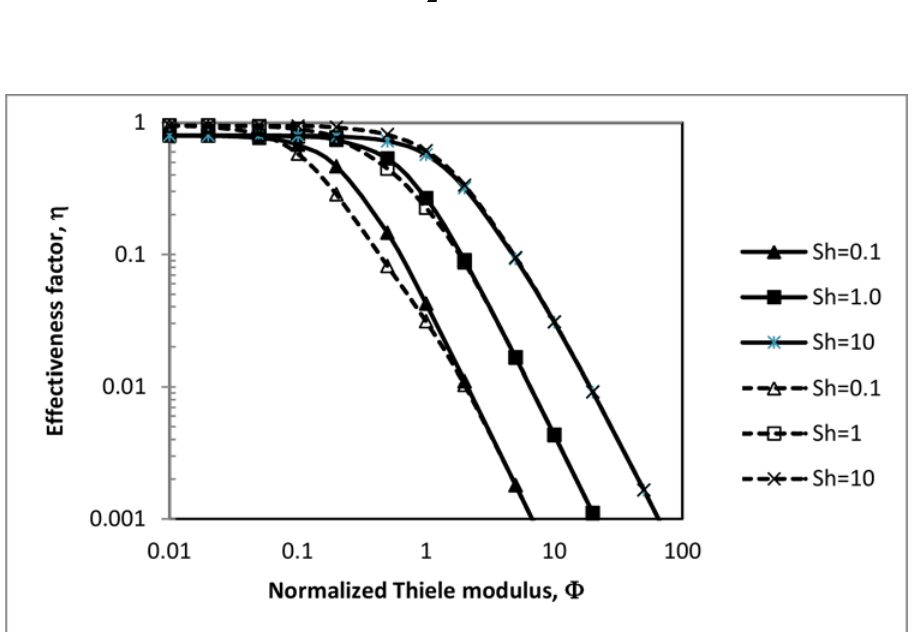
Fig 2. Effectiveness factors ( — ) from Eq (29) and asymptotes ( — ) from Eq (30) vs Thiele modulus at different Sherwood